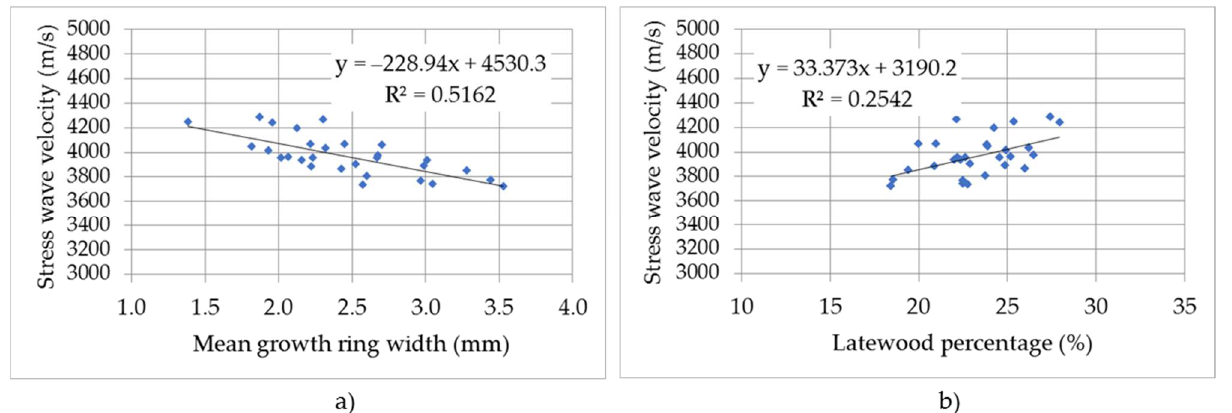
Figure 11. Relationship between longitudinal stress wave velocity and ( a ) growth ring width, and ( b ) the latewood percentage.